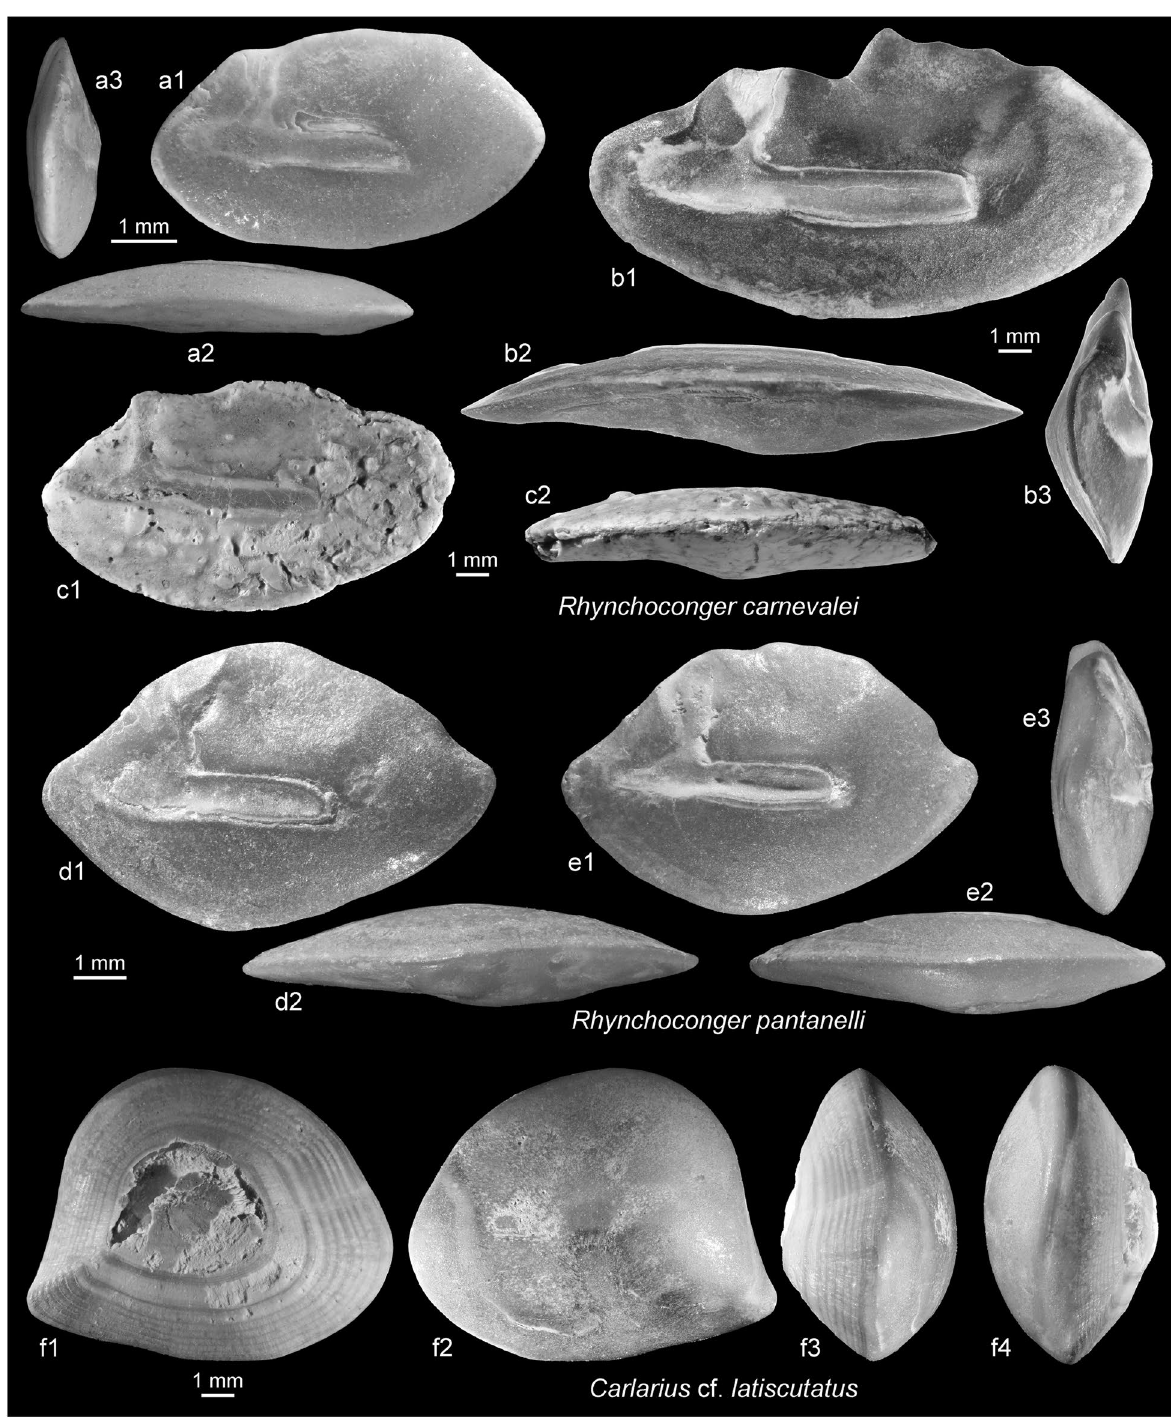
Fig. 11 Anguilliformes and Siluriformes. a – c Rhynchoconger carnevalei n. sp. 10a paratype, MGPT-PU 130,452 (reversed), Borelli, Piedmont, Italy, late Tortonian, b holotype, SMF PO 101.191, Agrigento, Sicily, Italy, Zanclean, c paratype, SMF PO 101.336 (reversed), Orciano near Pisa, Italy, Zanclean. d